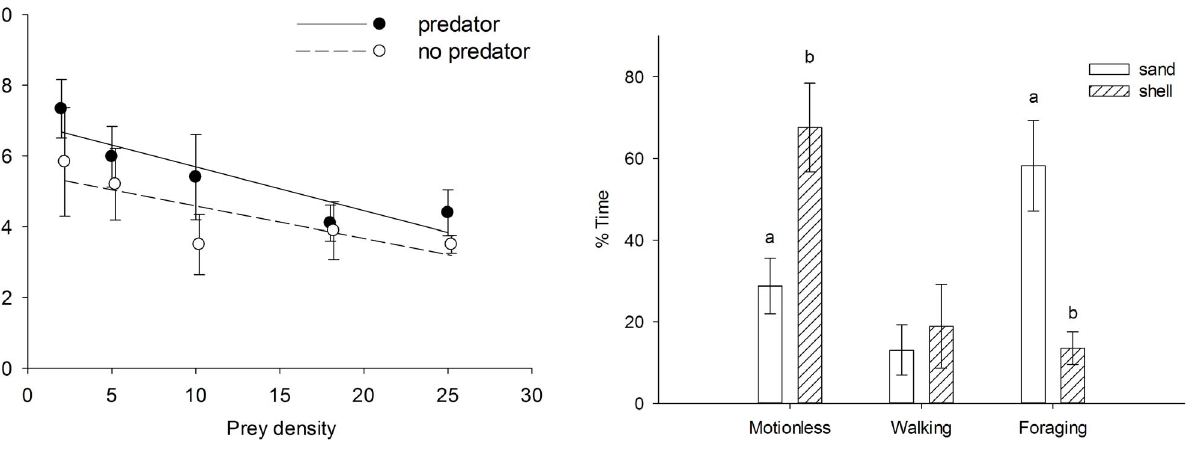
Figure 2. Average ( ± SE) prey crab crypsis index at five densities with (solid circles) and without (open circles) predator presence. The lines represent linear regressions for when predators were present (closed circles; crypsis=0.732 2 (0.0134 6 densi- ty), R 2 =0.172) and absent (open circles; crypsis=0.551 2 (0.00971 6 den- sity), R 2 =0.106).